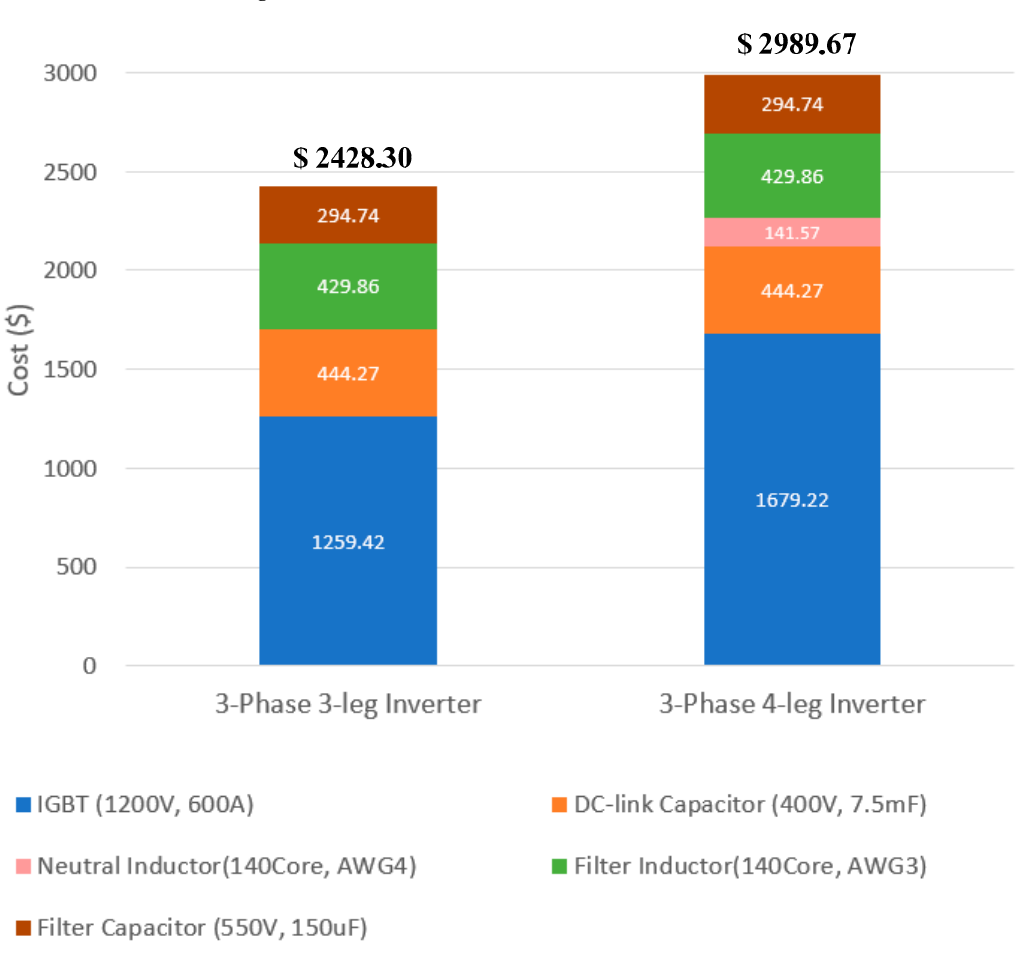
Figure 21. Cost comparison of 3-leg and 4-leg inverters using the cost model of the part.